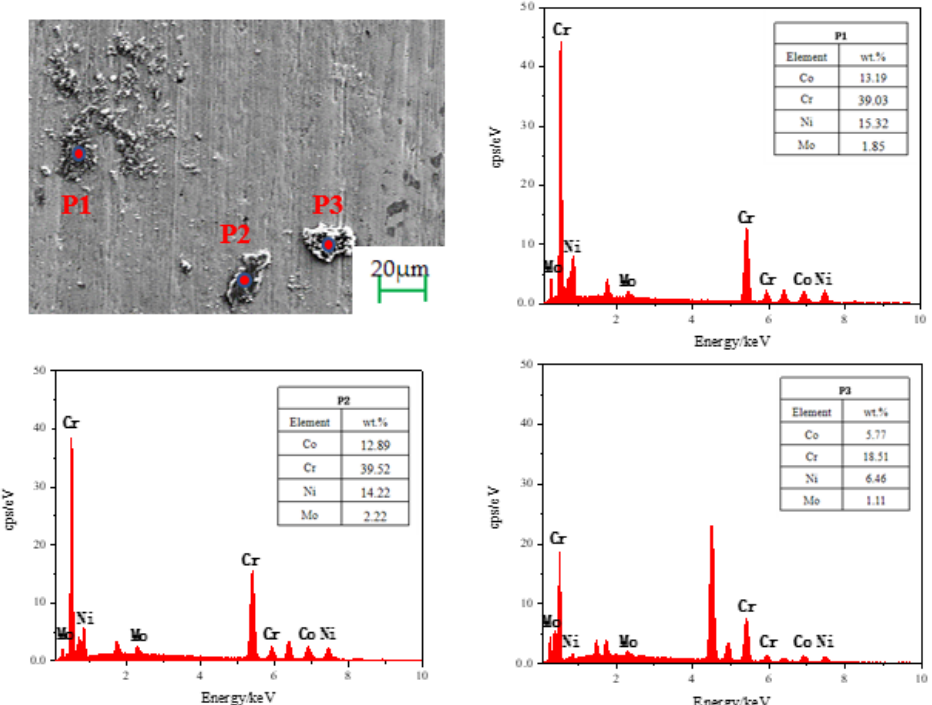
Figure 13. EDS point scanning spectrum of Mo 3 composite coating after friction wear.